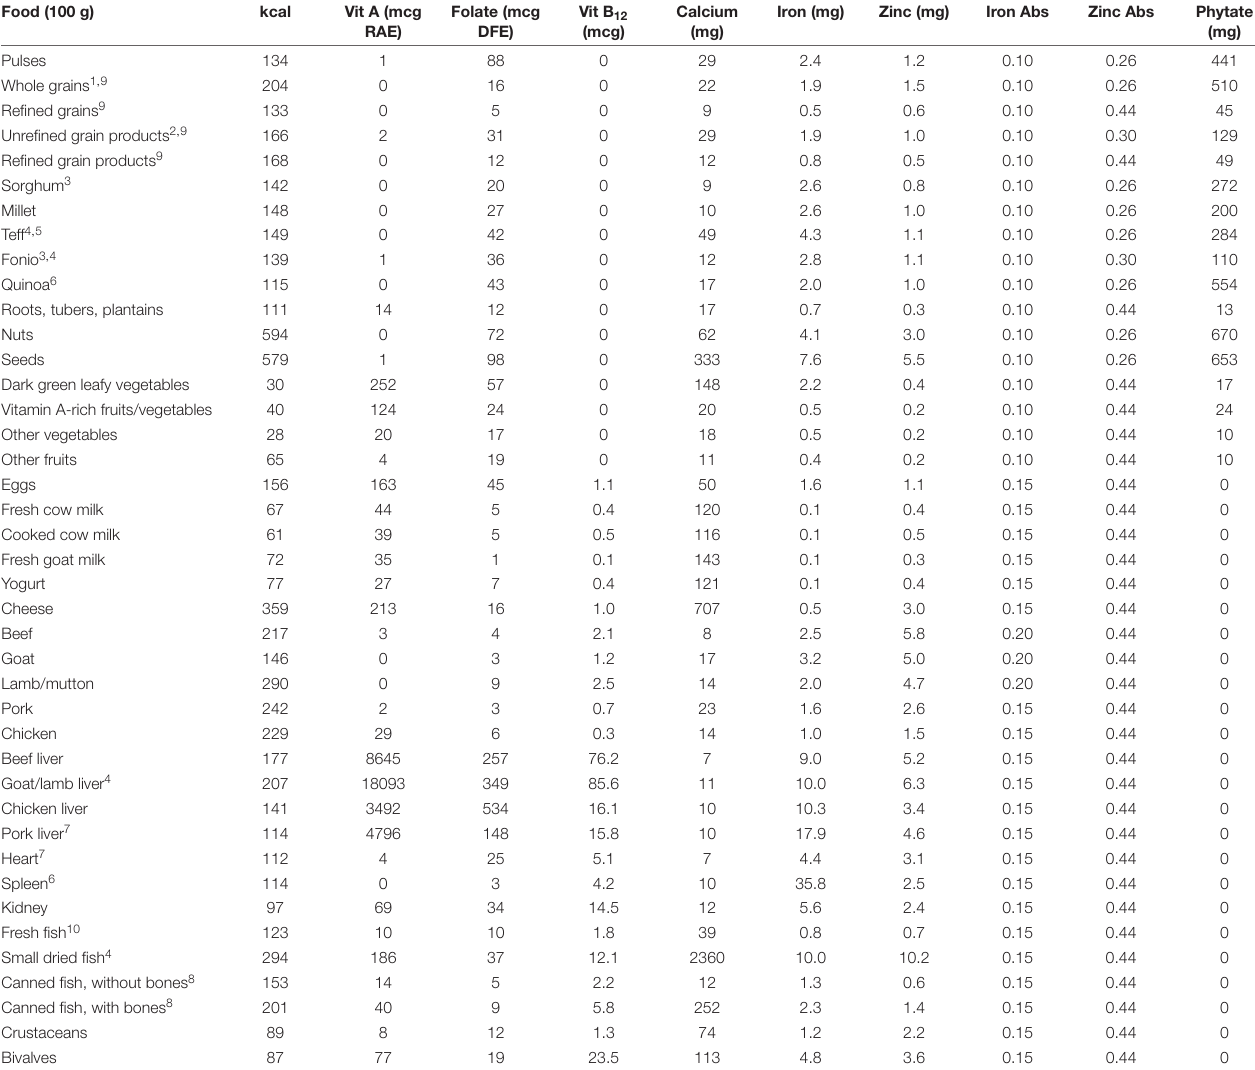
TABLE 2 | Global food composition database. Food (100